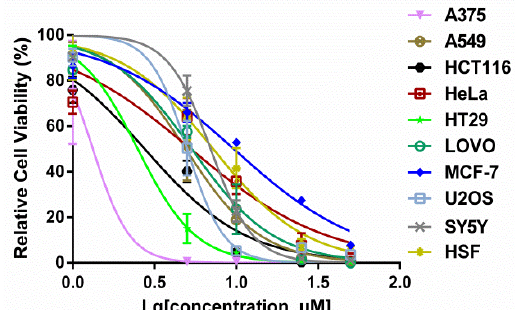
Figure 2. Cell viabilities of cell lines in response to 3u. The cell growth of nine cancer cell lines (A375, A549, HCT116, HeLa, HT29, LOVO, MCF7, SY5Y, and U2OS) and a normal cell line 9 (HSF) was measured using MTT assay 48 h after 3u exposure at various concentrations (0 µ M, 1 µ M, 5 µ M, 10 µ M, 25 µ M, and 50 µ M) ( n = 3). Table 1. IC 50 values of 3u on the growth inhibition of cell lines.